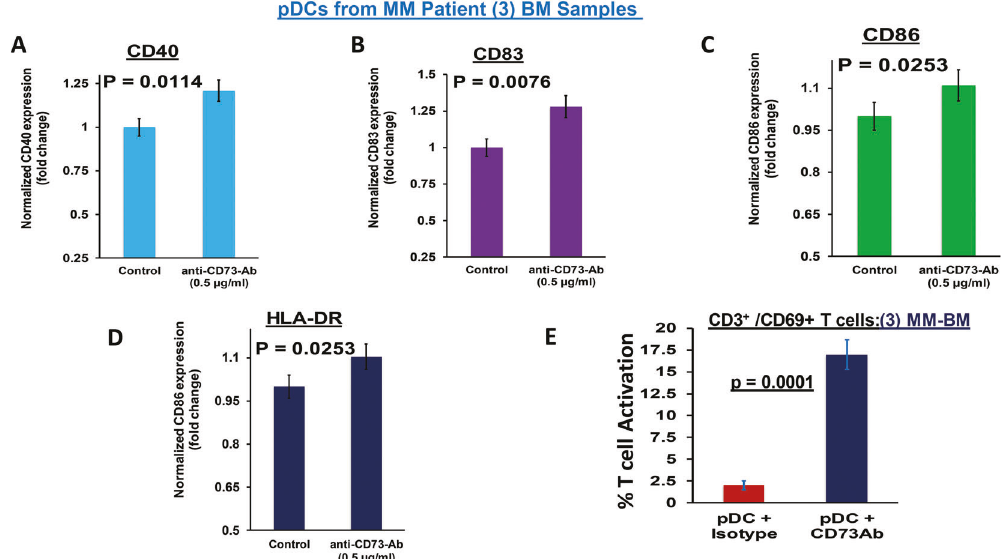
Fig. 4 CD73 blockade activates pDCs and enhances pDC-triggered T cell proliferation. ( A – D ) MM patient pDCs ( n = 3) were treated with anti-CD73 Ab (0.5 µg/ml) for 24 h, followed by multicolor staining. Expression of pDC activation/maturation markers CD40, CD83, CD86, and HLA-DR were assessed using fl ow cytometry. Fold change in treated versus untreated pDCs is shown (mean ± SD; p < 0.05; n = 3). E MM patient pDCs ( n = 3) were co-cultured for 3 days with autologous T cells at 1:10 (pDC:T) ratio, in the presence or absence of anti-CD73 Ab (0.5 µg/ml). Viable CD3 + T cells were analyzed for the expression of CD69 activation marker using anti-CD3-FITC and anti-CD69-APC-Cy7 Abs, and quanti fi ed by FACS (mean ± SD; P < 0.05, n = 3). [Note: The percentage of CD3 + /CD69 + T cells denotes activated T cells in the presence of anti-CD73 Ab; three myeloma bone marrow (MM BM) samples were